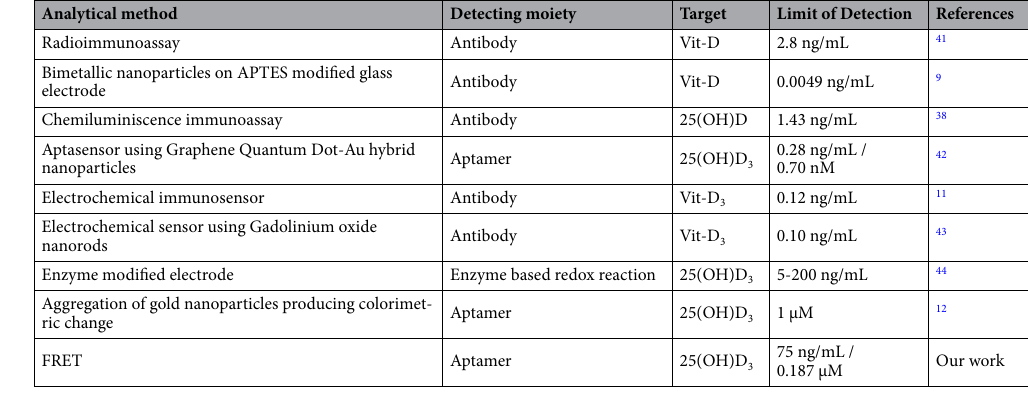
Table 1. Comparison of various techniques available for detection of Vit D.